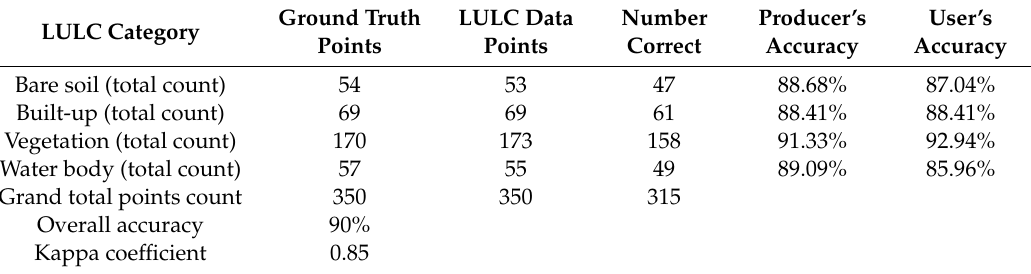
Table 3. The error matrix for the classified image of